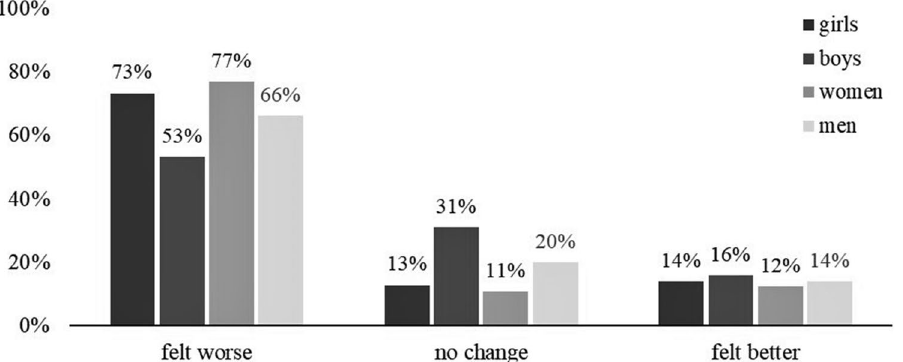
Figure 2. Changes in the general mental health reported by gender (males vs. females) and age group (adolescents vs. young adults) (N =